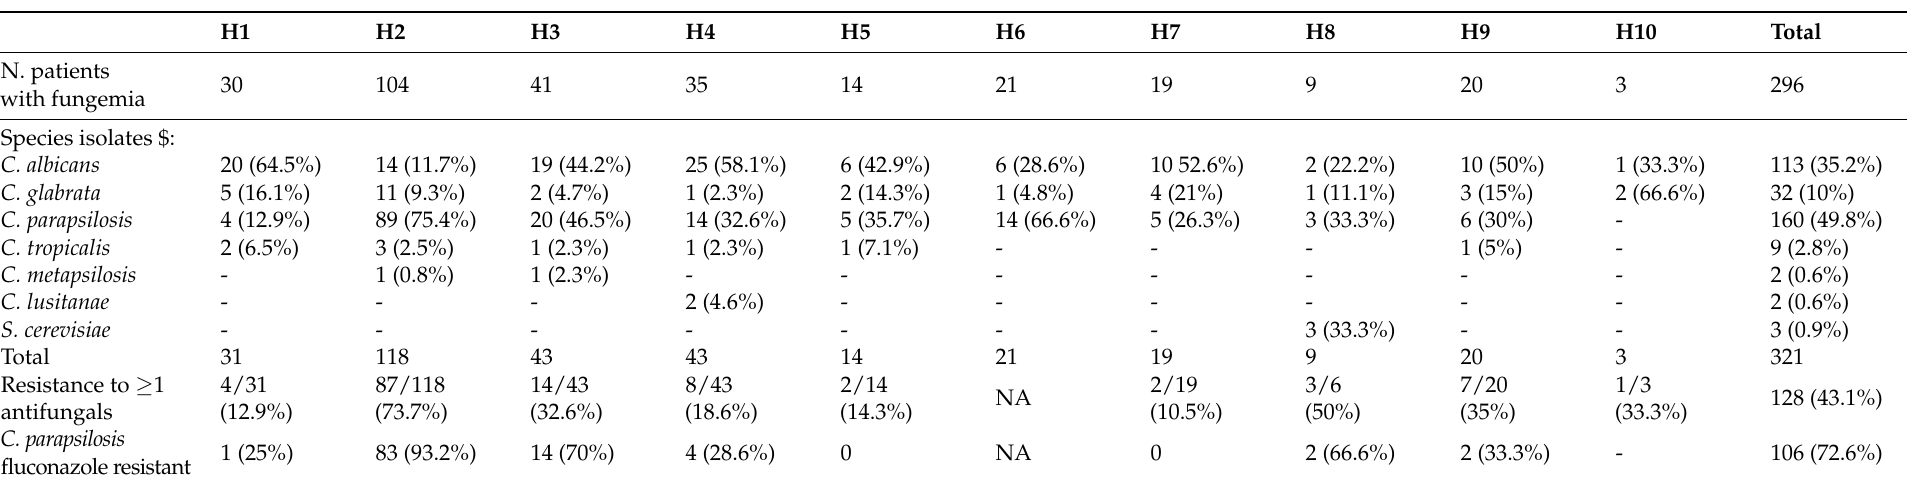
Table 3. Species distribution and antifungal resistance rate in the 10 participating hospitals